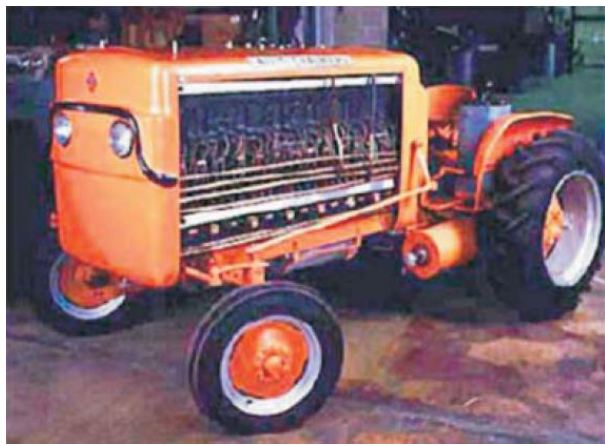
Fig. 21. Allis-Chalmers AC D-12 fuel cell tractor [14,